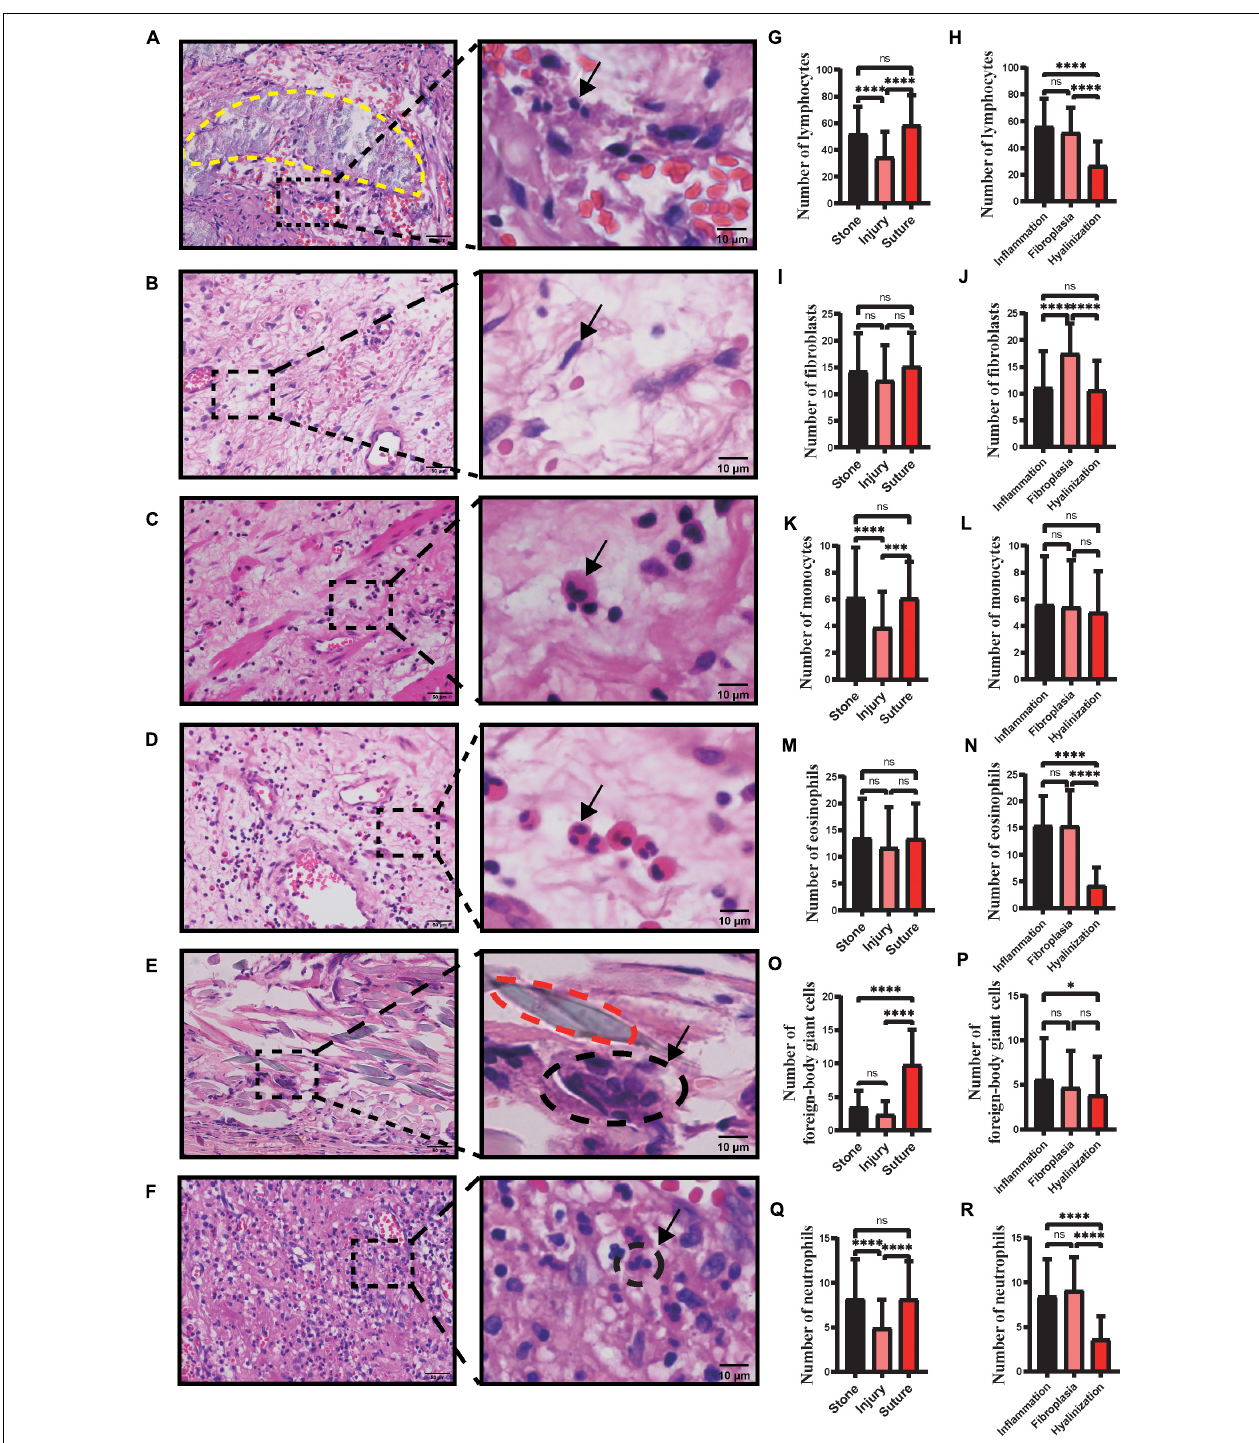
FIGURE 2 | Number of different types of inflammatory cells and fibroblasts in ureteral strictures. HE staining of lymphocytes (A) , fibroblasts (B) , monocytes (C) , eosinophils (D) , foreign-body giant cells (E) and neutrophils (F) at the ureteral stricture site. Arrows point to typical fibroblasts and inflammatory cells. The yellow dashed line (A) contains the stone and the red dashed line (E) contains the suture. Left column scale bar, 50 µ m; right column scale bar, 10 µ m. Number of lymphocytes (G) , fibroblasts (I) , monocytes (K) , eosinophils (M) , foreign-body giant cells (O) , neutrophils (Q) in ureteral strictures due to stones, injury, sutures. Number of lymphocytes (H) , fibroblasts (J) , monocytes (L) , eosinophils (N) , foreign-body giant cells (P) and neutrophils (R) in three pathological subtypes: inflammation, fibroplasia and hyalinization (ns, not significant; ∗ p < 0.05; ∗∗∗ p < 0.001; ∗∗∗∗ p < 0.0001).